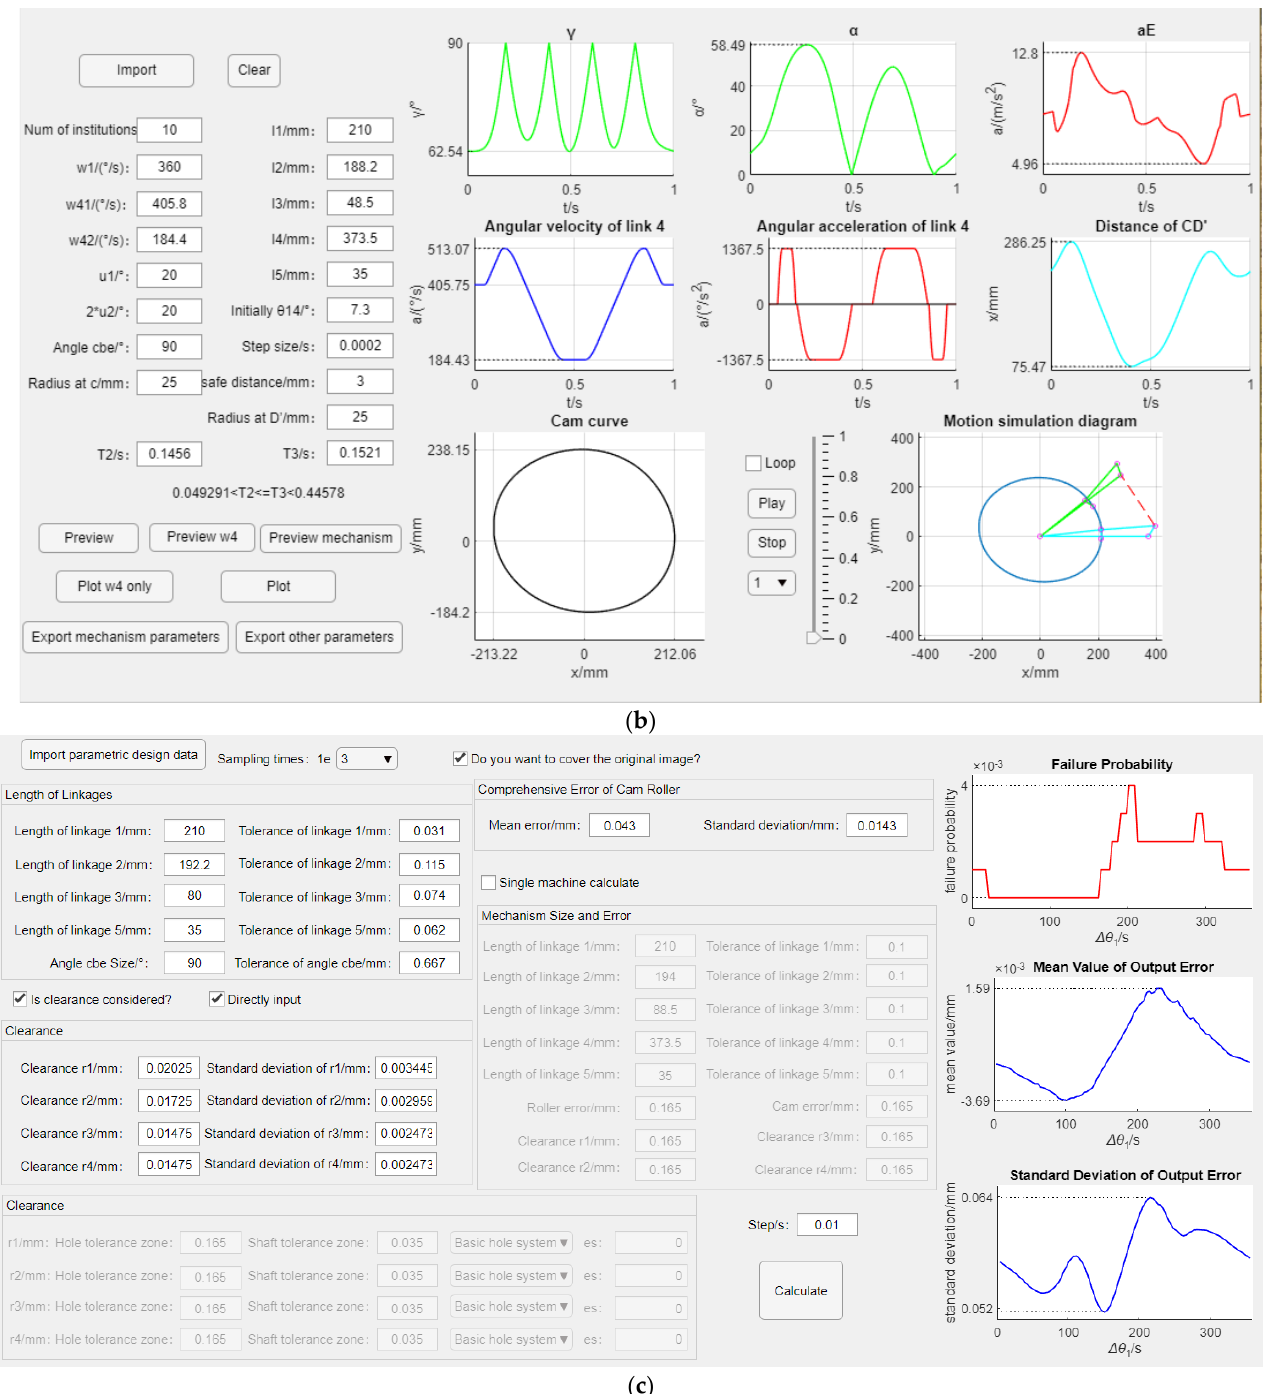
Figure 7. Software interface. ( a ) Optimization module ( b ) Parameter calculation module ( c ) Reliability analysis module.